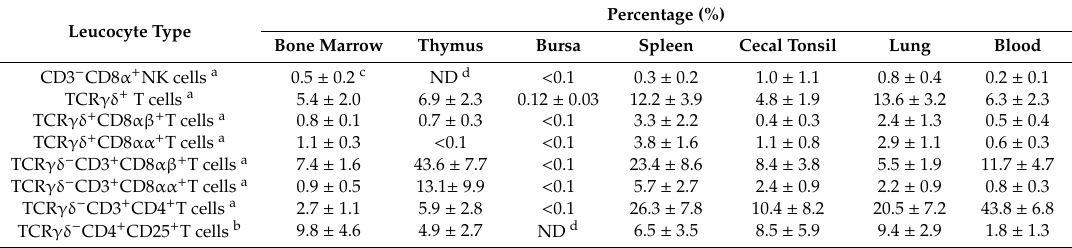
a Percentage of T lymphocytes were derived from a lymphocyte gate based on forward scatter (FSC) versus side scatter (SSC). b Percentages of CD4 + CD25 + T cells are expressed as a percentage out of CD4 + T cells. c Values are means ± SD. n = 6. d ND, not